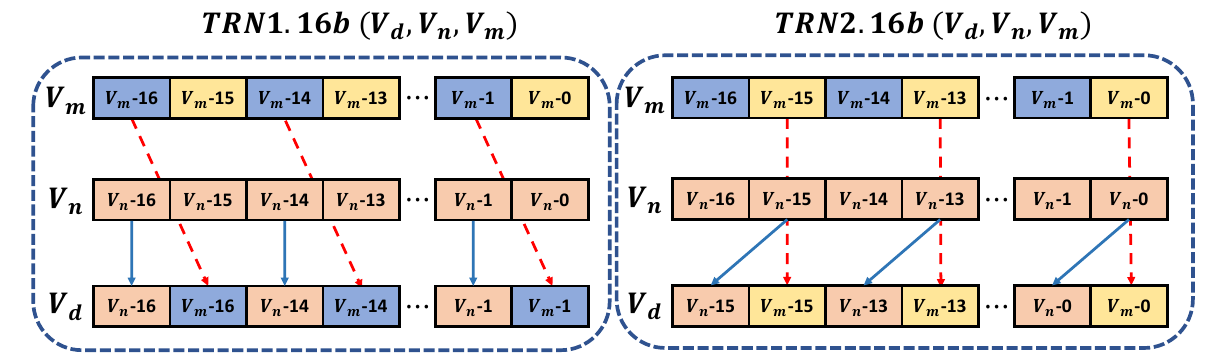
Figure 1. Transpose process of TRN1 .16 b and TRN2 .16 b instructions [13].